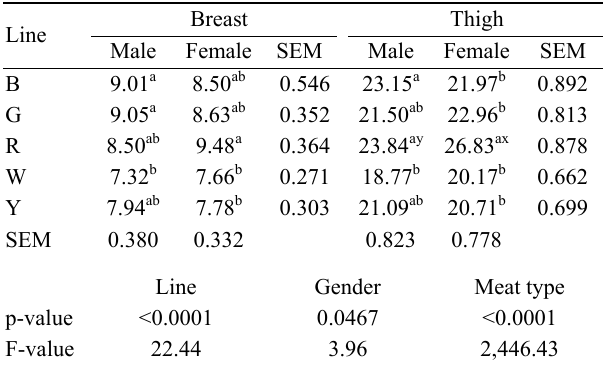
SEM, standard error of mean; B, black; G, grey-brown; R, red-brown; W, white; Y, yellow-brown. a,b Different letters among breeds differ significantly (p<0.05). x,y Different letters between genders differ significantly